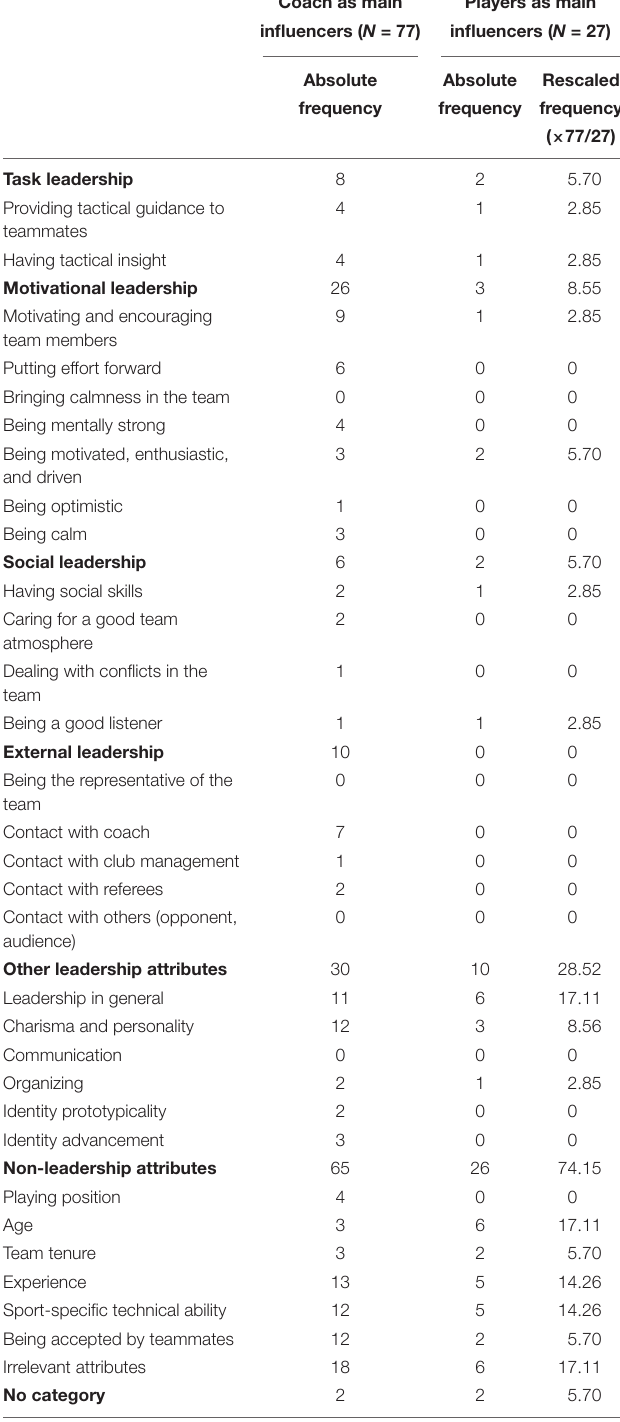
TABLE 5 | Frequency analysis of the characteristic attributes of the current team captain if the selection was mainly made by either the coach or the